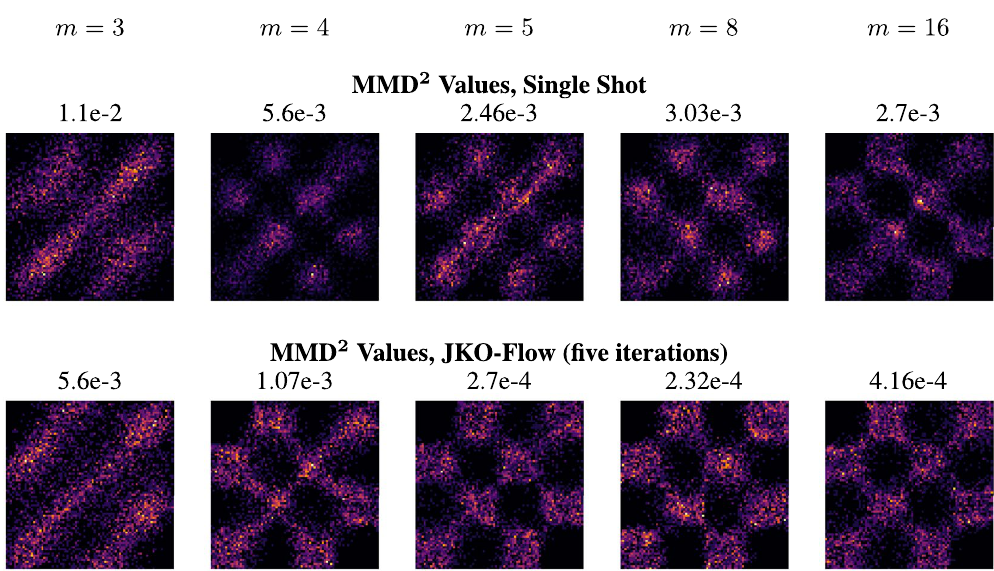
ρ 0 using the standard single shot approach (top (cid:31)